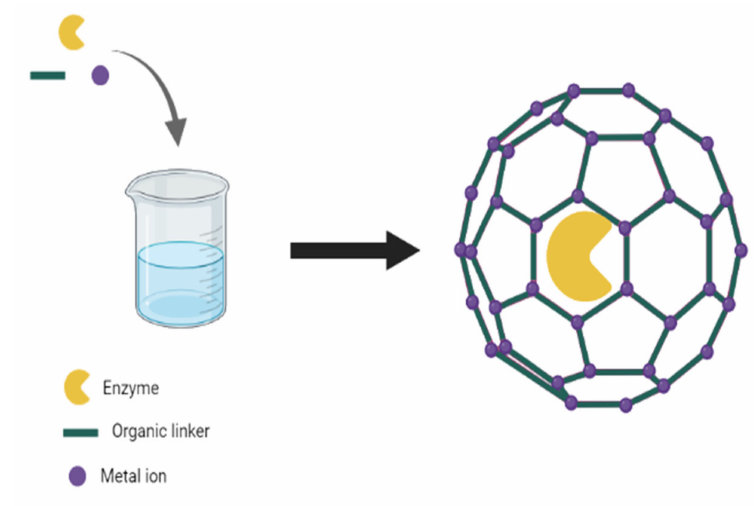
Figure 3. Schematic representation of the co-precipitation method.